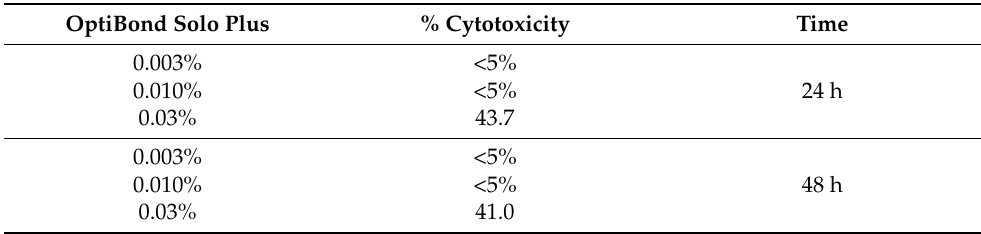
Table 2. Changes in the integrity of Hs27 fibroblast cell membranes after the 24- and 48-h incubation with OptiBond Solo Plus tested by the LDH Cytotoxicity Kit. Data referenced to values obtained for the control (0.1% DMSO-treated